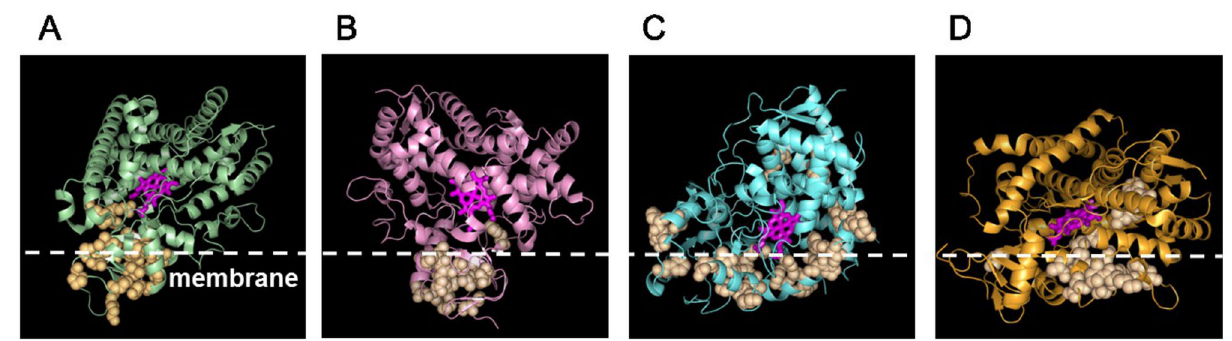
Figure 2. Membrane-binding networks for different CYP isoforms. Residues identified as belonging to membrane-binding networks were mapped to the molecular structures of CYP1A (PDB code 2HI4; A ), CYP2C (PDB code 1R9O; B ), CYP3A (PDB code 1W0E; C ), and CYP2D (PDB code 2F9Q; D ). The location of the membrane-bound portion of the enzyme partly determines which substrates can access each enzyme. The heme molecule is shown in a stick representation, and the residues belonging to the functional networks are shown as spheres. The position of the membrane line was qualitatively positioned based on the location of the residues in the membrane-binding networks. doi: